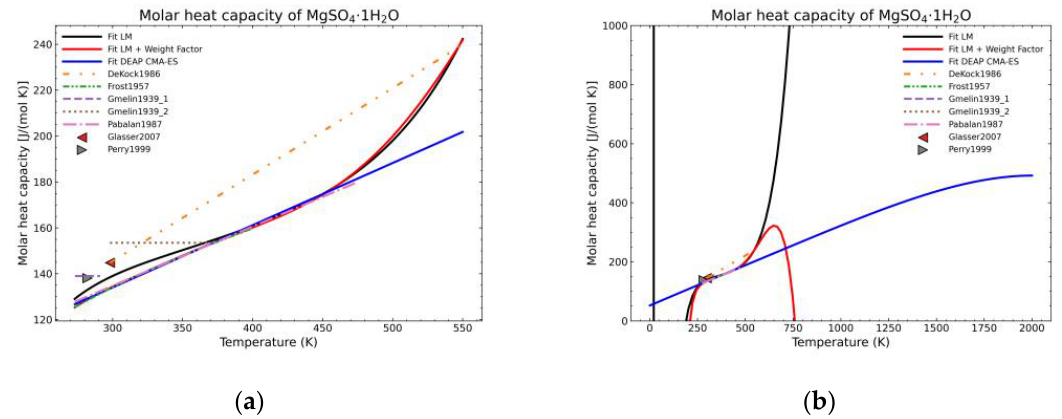
Figure 6. Comparison of the different fit results of MgSO 4 ·1H 2 O showing: ( a ) literature points region; ( b ) extended range until 2000 K.